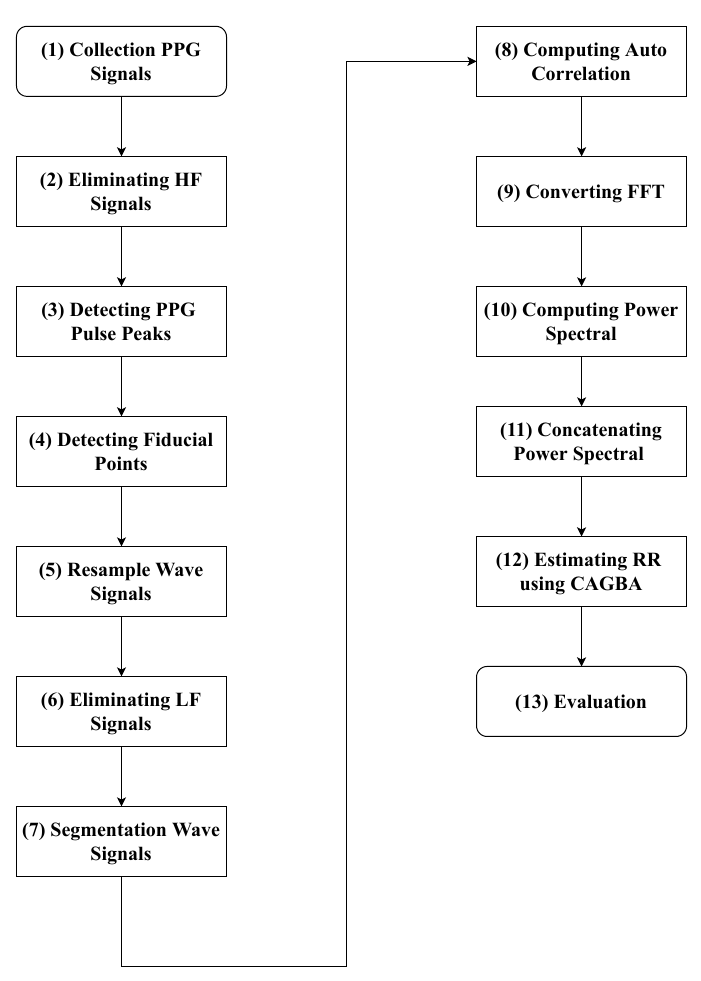
Figure 1. Block diagram of the proposed methodology using CAGBA